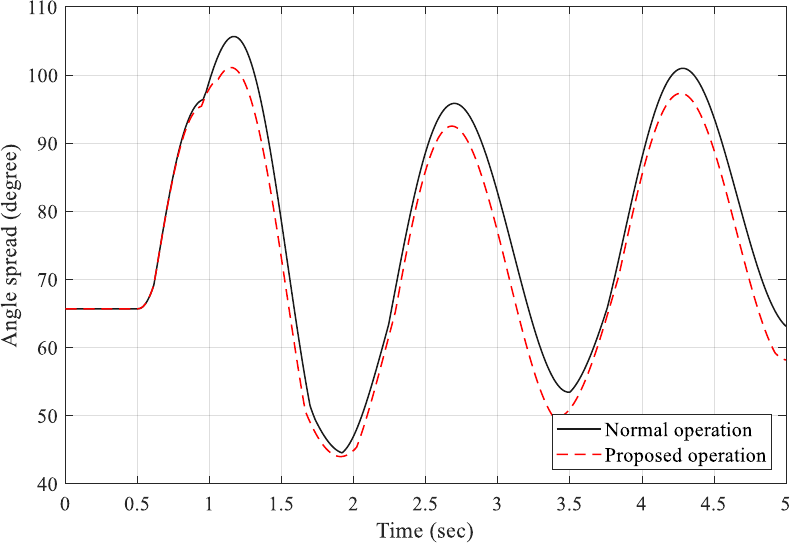
Figure 17. The angle spread for the load side event.